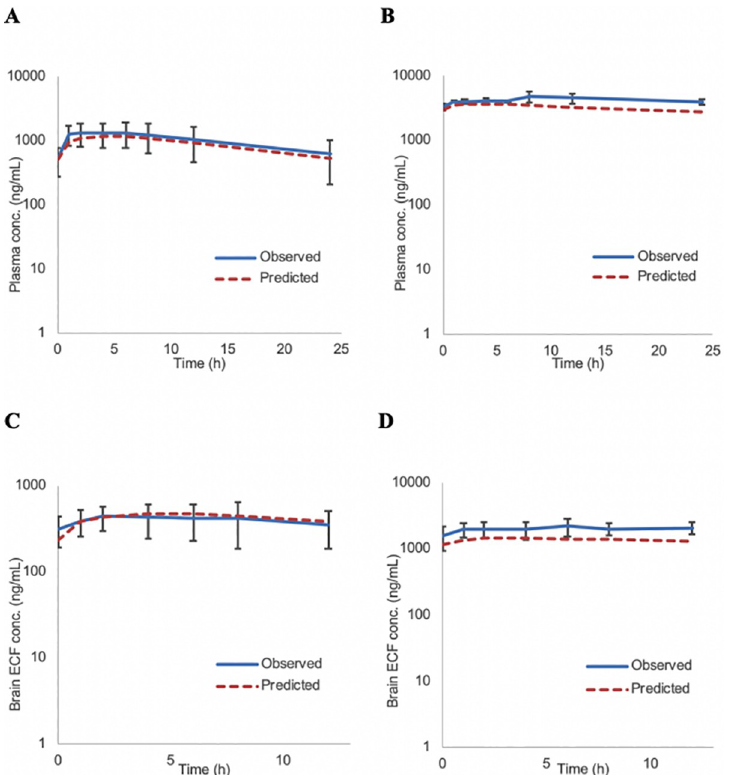
Fig 5. Model-predicted and observed plasma/ brain ECF concentration- time profiles of letrozole at steady state in male (A, C) and female (B, D) rats obtained employing the Simcyp v17 animal simulator. Simulations were performed in virtual rodent population following extravascular dosing of 4 mg/kg of letrozole for 5 and 11 days in male and female rats respectively. Brain tissue concentrations were additionally corrected for f u , brain of 0.58 to acquire the brain ECF concentrations. Observed data; mean ± SD; the solid and dashed lines represent overall mean concentration–time profiles for the observed and predicted data respectively.